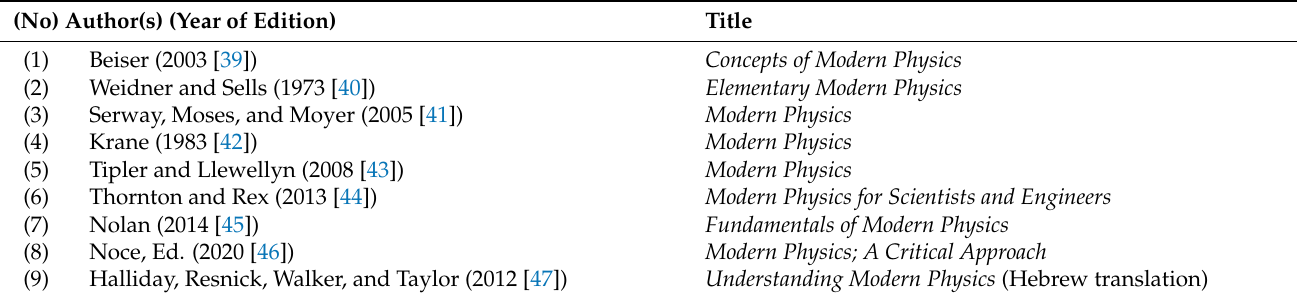
Table 2. List of the physics textbooks